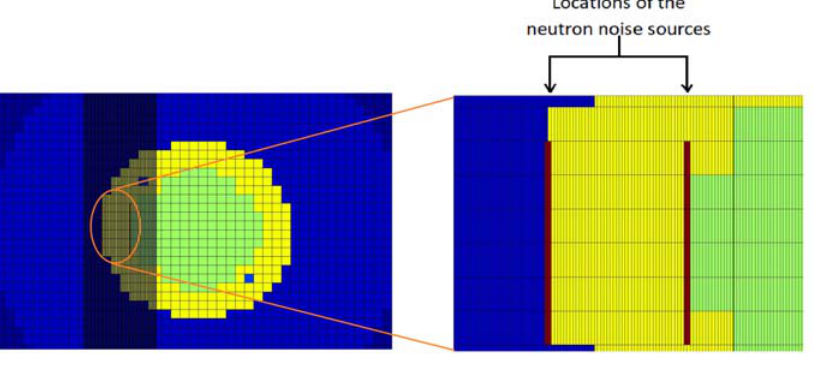
Figure 4: Radial cross-section of the reactor model (left) & neutron noise sources